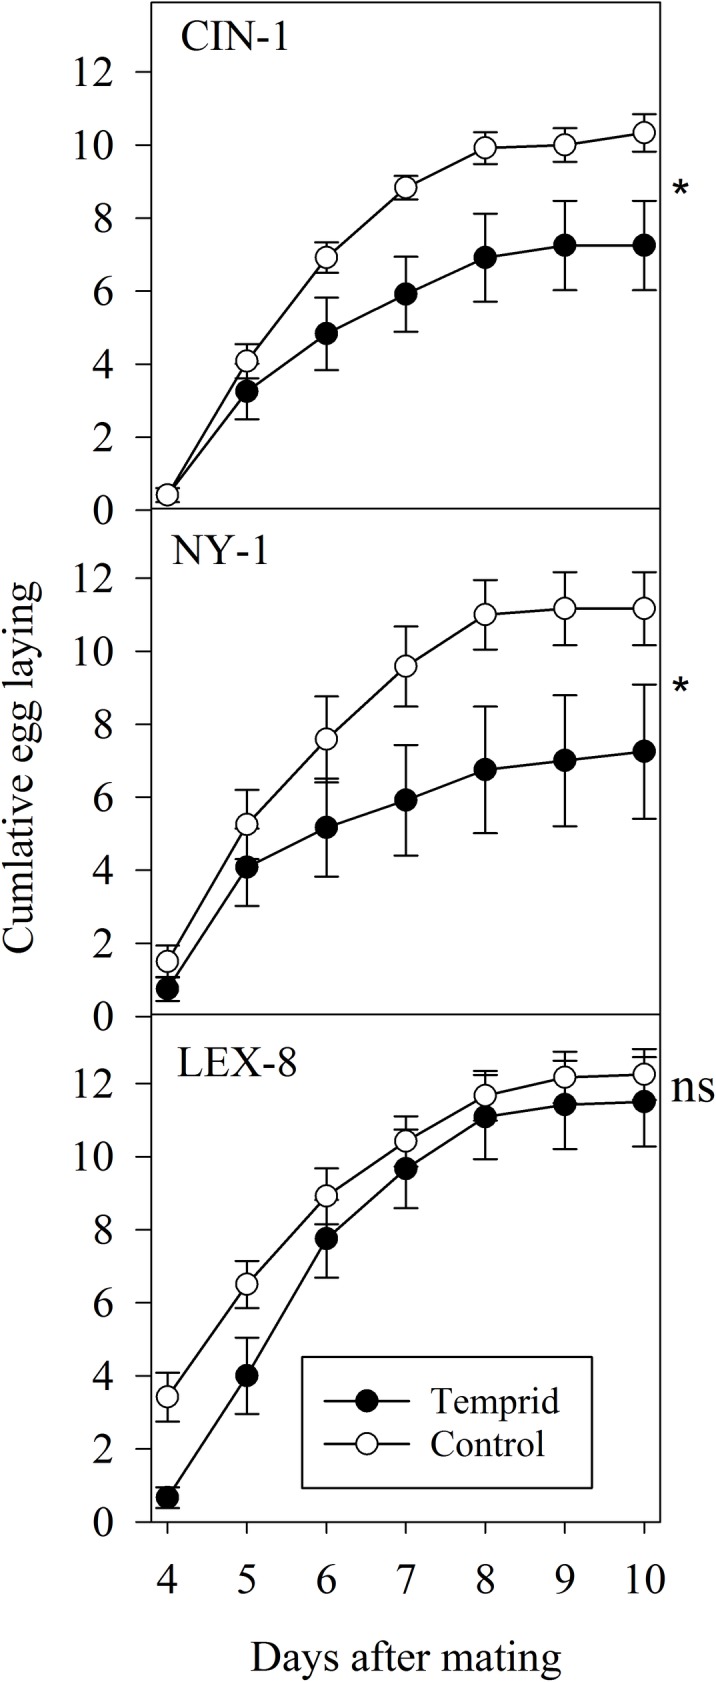
Cumulative egg laying for three strains when sublethal exposure occurred after mating had taken place.The total number of eggs laid significantly declined for the susceptible and moderately resistant strains (CIN-1 and NY-1), but not for the most resistant strain (LEX-8) (Paired t-tests, *p<0.05).